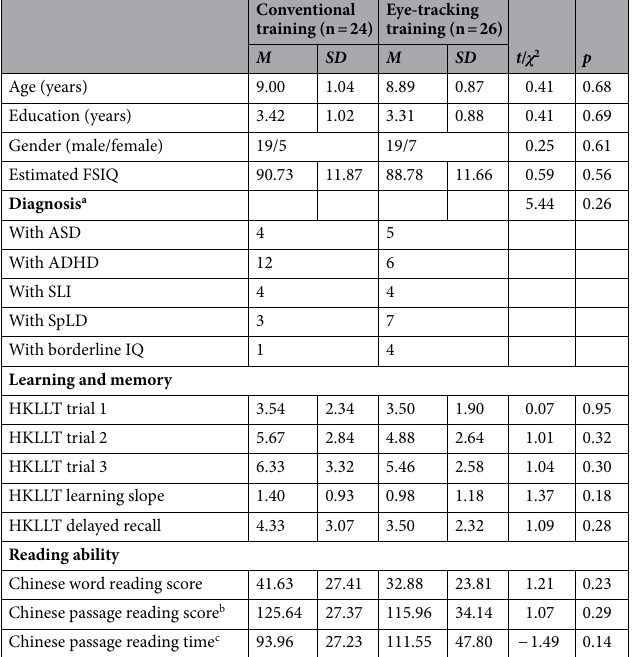
Table 1. Demographic characteristics and baseline cognitive performance of the Conventional Training and Eye-tracking Training groups. FSIQ Full-scale intelligence quotient, ASD Autism spectrum disorders, ADHD Attention-deficit/hyperactivity disorder, SpLD Specific learning disorder, SLI Specific language impairment, HKLLT Hong Kong list learning test. a Participants diagnosed with ASD, ADHD, SpLD or SLI include those with single diagnosis and those with other comorbidities. b n = 22 in Conventional Training group. c n = 21 and 25 in Conventional Training and Eye-tracking Training group